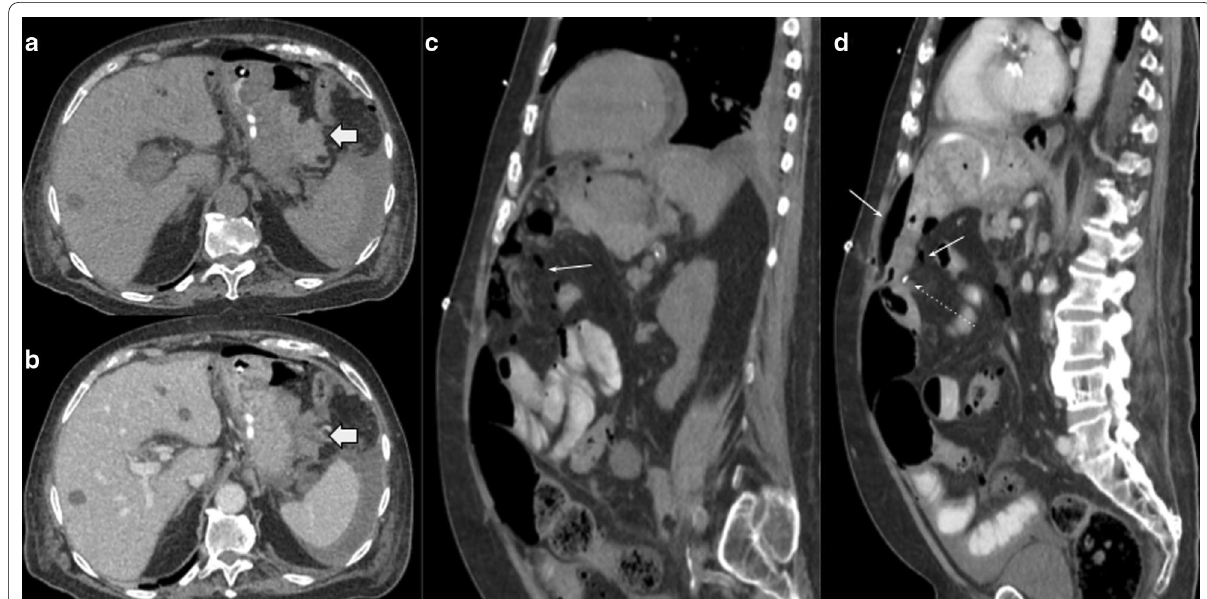
Fig. 24 Gastrojejunostomy dehiscence. 87-year-old male patient with complicated early postoperative duodenopancreatectomy with Y de Roux and gastrojejunostomy due to pancreatic adenocarcinoma. Axial and sagittal non-contrast ( a – c ) and portal venous phase ( b – d ) CT scan. Shows a blood collection (big arrows in a and b ) associated with pneumoperitoneum (thin arrows in c and d ) adjacent to the gastroenteric anastomosis (dotted arrow in d ). Urgent laparoscopy confirmed gastroenteric anastomosis dehiscence